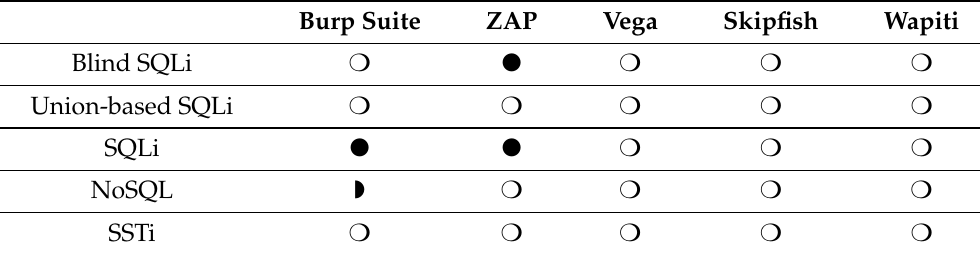
Table 8. Types of detected and undetected